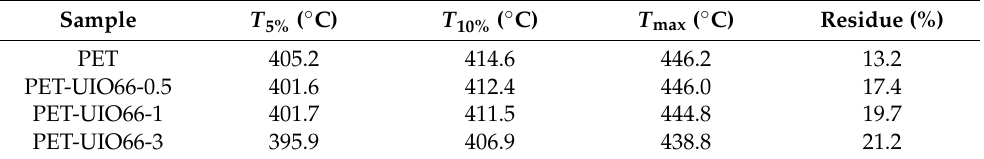
Figure 9. The TGA curves of the PET and the PET/UIO-66 nanocomposites. Table 4. Thermal stability of PET and PET/UIO-66 nanocomposites.